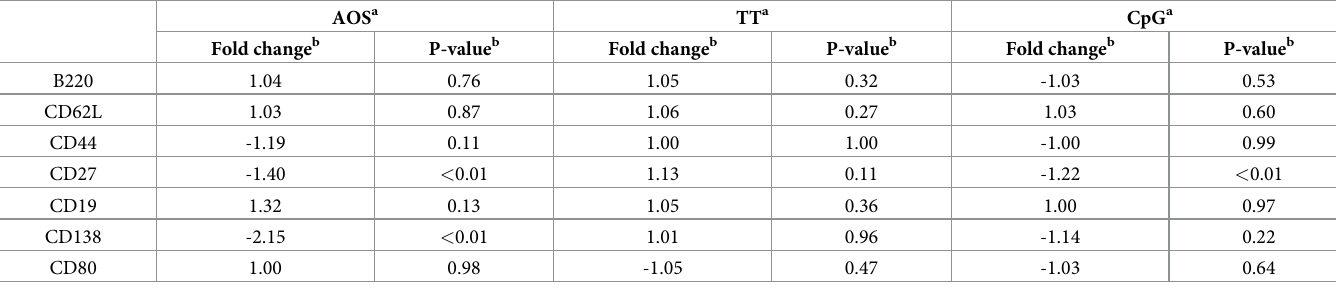
Table 2. Impact of AOS, tetanus toxoid and CpG on lymphocyte